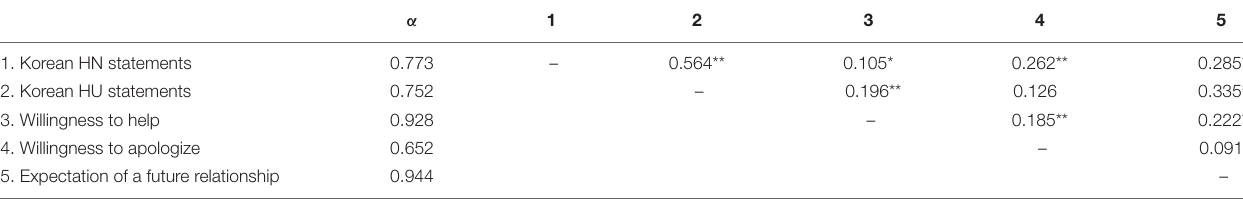
TABLE 4 | Reliability indices and correlations between main variables (Study 2, N = 209).